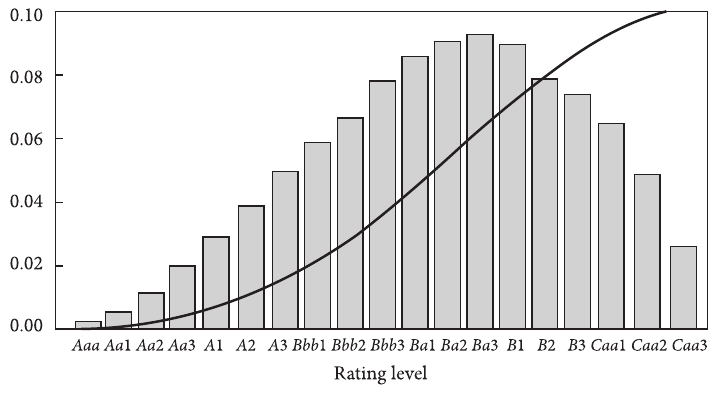
Figure 4. Rating results (source: own